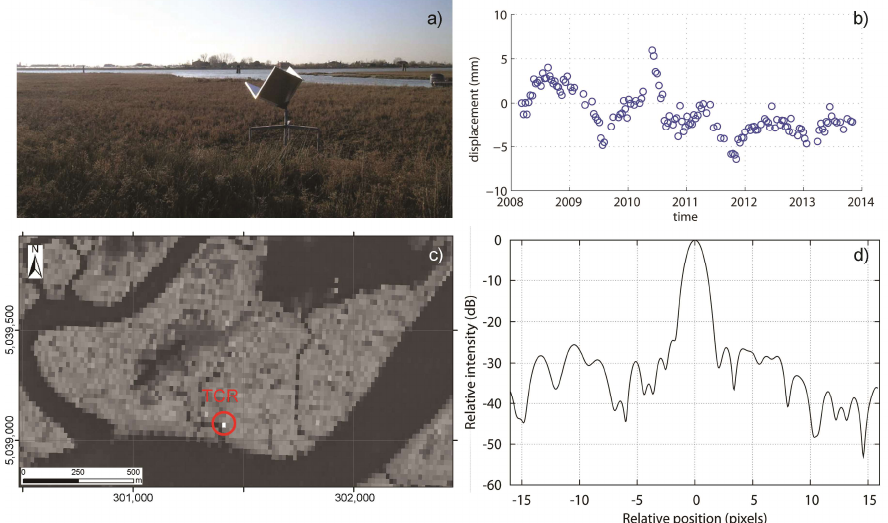
Figure 5. Example of displacement analysis of a TCR using TerraSAR-X images: ( a ) photograph of the TCR installed in a salt marsh located in the northern Venice lagoon; ( b ) time series of displacements obtained using TerraSAR-X data over the 2008–2013 period; ( c ) backscattering intensity image of the salt marsh highlighting the larger intensity (white pixel) in correspondence of the TCR; and ( d ) normalized intensity as a function of range for one for TerraSAR-X